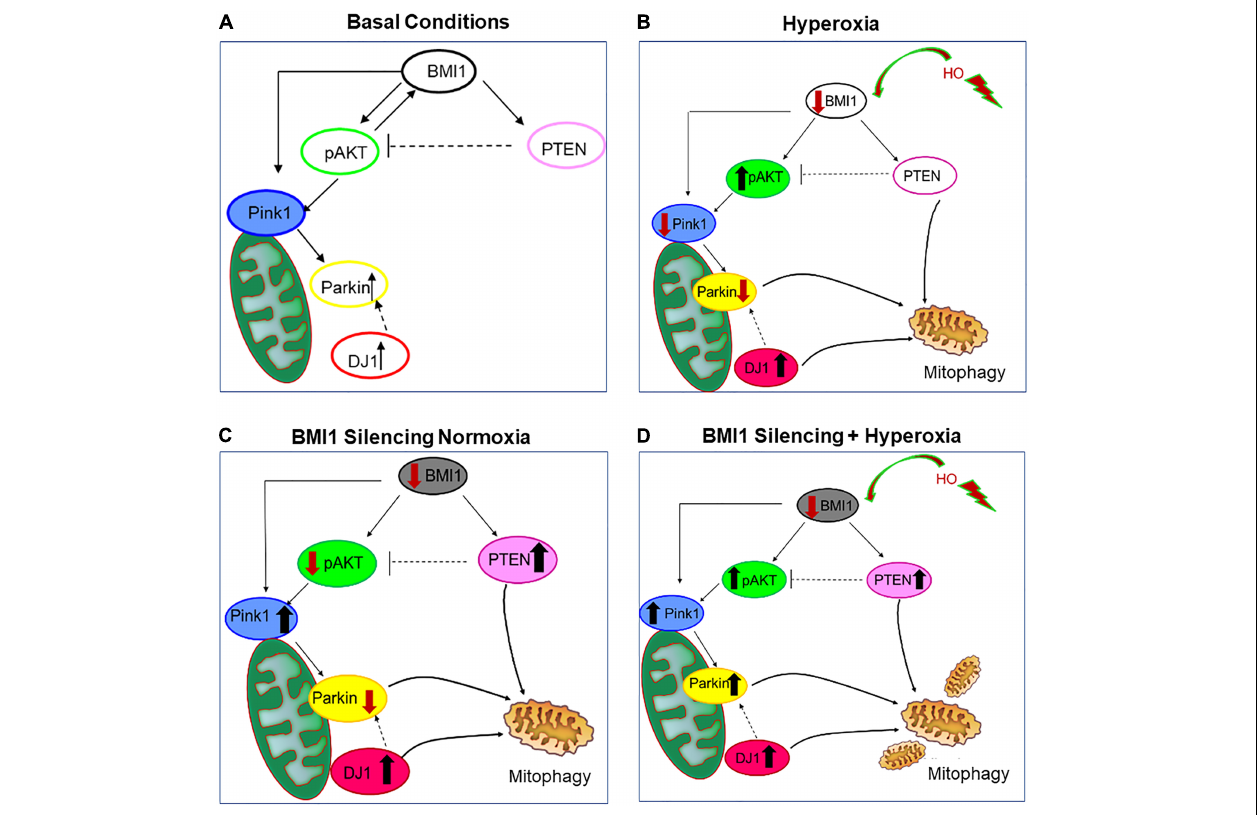
FIGURE 7 | Pathway proposed downstream of BMI1 silencing in H441 cells. (A) Basal conditions, schematic representation of protein expression under normoxia, and normal expression of BMI1. (B) Hyperoxia, protein expression in H441 cells downstream of decreased expression of BMI1. (C) Representation of protein expression downstream of BMI1 silencing in normoxia. (D) The BMI1 Silencing + Hyperoxia panel represents the effects of BMI1 silencing in hyperoxia. Hyperoxia was defined as cell exposure to concentrations of oxygen higher of 80% for 48